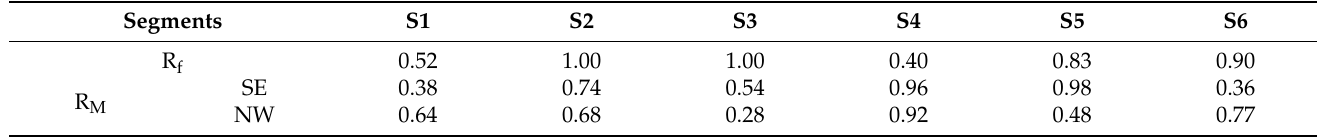
Table 17. The data of the average wind speed ratio and skyline rhythm